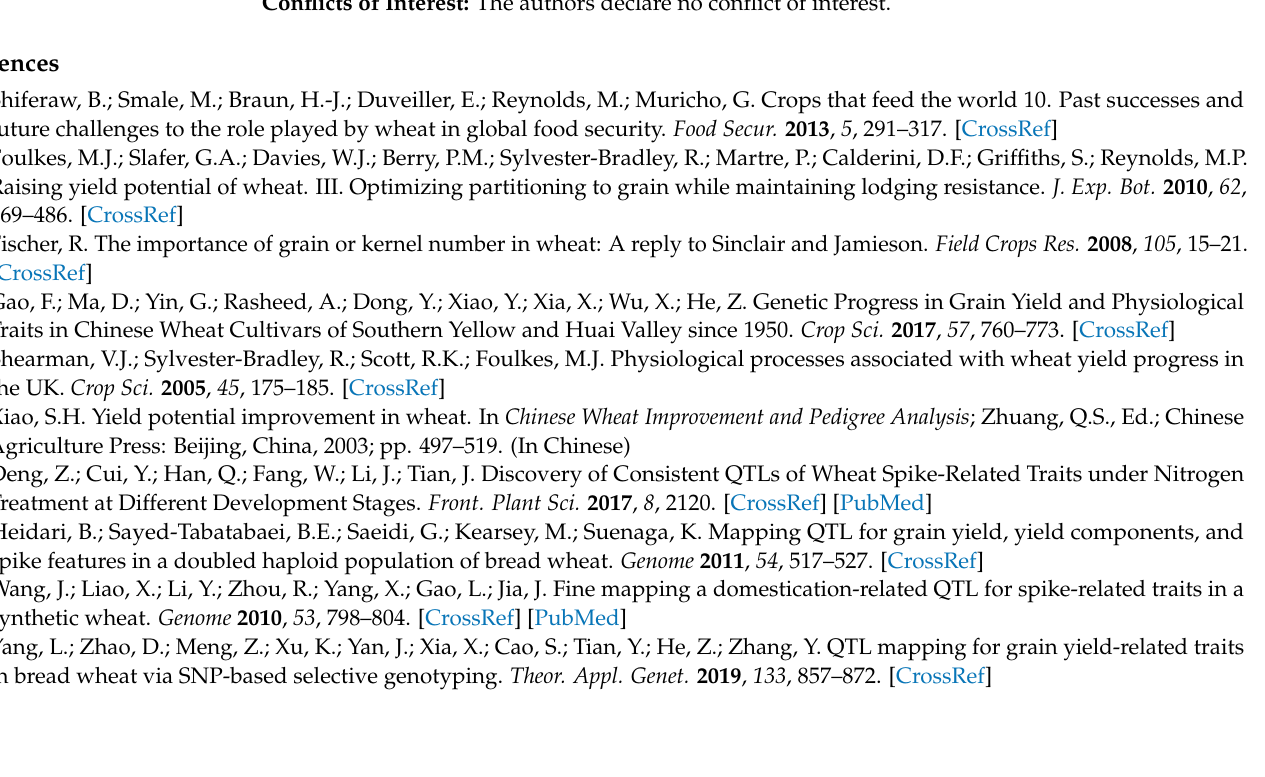
plot of principal components was used to find the optimal number of PCs for the GWAS. The eigenvalues start to form a relatively straight line after the fourth principal component. Figure S3: Manhattan plots for spike-related traits including spikelet density (A), spike length (B) and total spikelet number per spike (C) from the GWAS. The arrowhead indicates the peak signal containing the candidate pleiotropic genes. Figure S4: The expression profiles of TraesCS4B02G037000 and TraesCS4B02G037200 in different tissues and organs of wheat. The expression data of wheat genes were collected from the WheatExp database (https://wheat.pw.usda.gov/WheatExp/, accessed on 30 November 2021). Table S1: Pedigree information of a panel of 255 derivative lines and 4 elite commercial varieties. Table S2: The VCF file of 310,097 SNPs in all materials after removing nucleotide variations with missing rates ≥ 0.1 and minor allele frequency (<0.05). Table S3: All phenotype data were provided including 2-year replicates. Table S4: KASP primer sequences used in this study. Table S5: The list of marker-trait associations (MTAs) for 12 investigated traits across all the environments. Table S6: Other pre-breeding lines, including early generation lines and derivative breeding lines, were chosen for detecting the AX-109286577 SNP genotype on chromosome 4BS. Table S7: High- confidence genes were annotated in the Chinese Spring reference genome from the 26.49 Mb to 28.95 Mb physical regions of chromosome